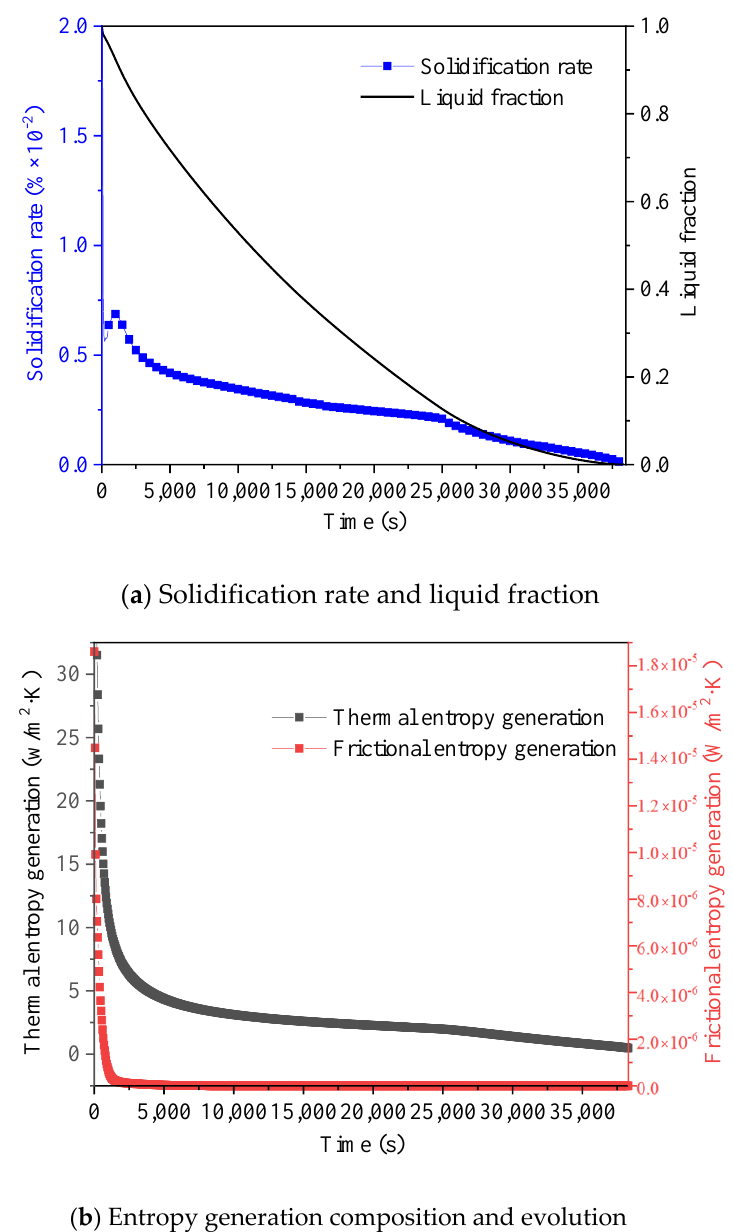
( b ) Entropy generation composition and evolution Figure 8. Liquid fraction and entropy generation for solidification process. Figure 9 shows the lag time of no-fin case in solidification. The temperature of each point decreases as the solidification progresses, and latent heat is released when the solidification point is reached, then the temperature further decreases. Interestingly, different from melting, the radial lag time of solidification is greater than the circumferential lag time. This is because heat conduction is the main heat transfer mode of solidification, which causes solidification to be slower and more uniform than melting.